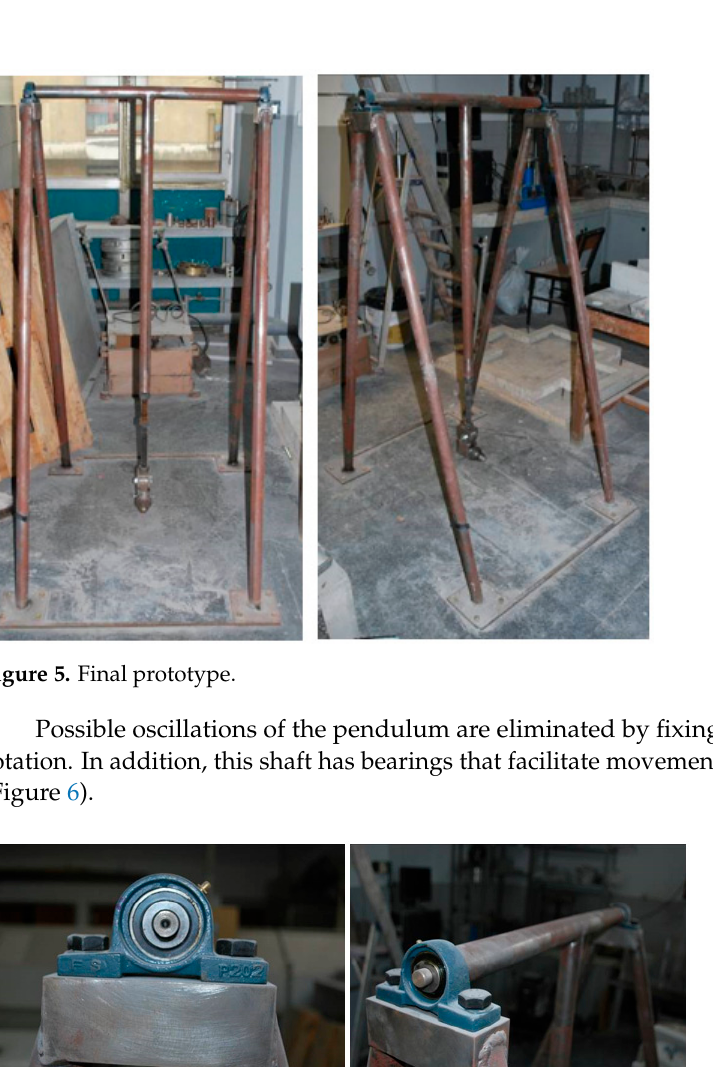
Figure 8. Pick-holder, threaded rod and pendulum arm. An electronic encoder, of the REV series and of the Italian brand Elap, is installed on the pendulum axis to correctly measure the starting angle of the pendulum movement and to determine the impact energy given by the Equation (1). 𝐸 = 𝑚𝑔𝑏(cid:4666)1 − cos 𝜃(cid:4667)